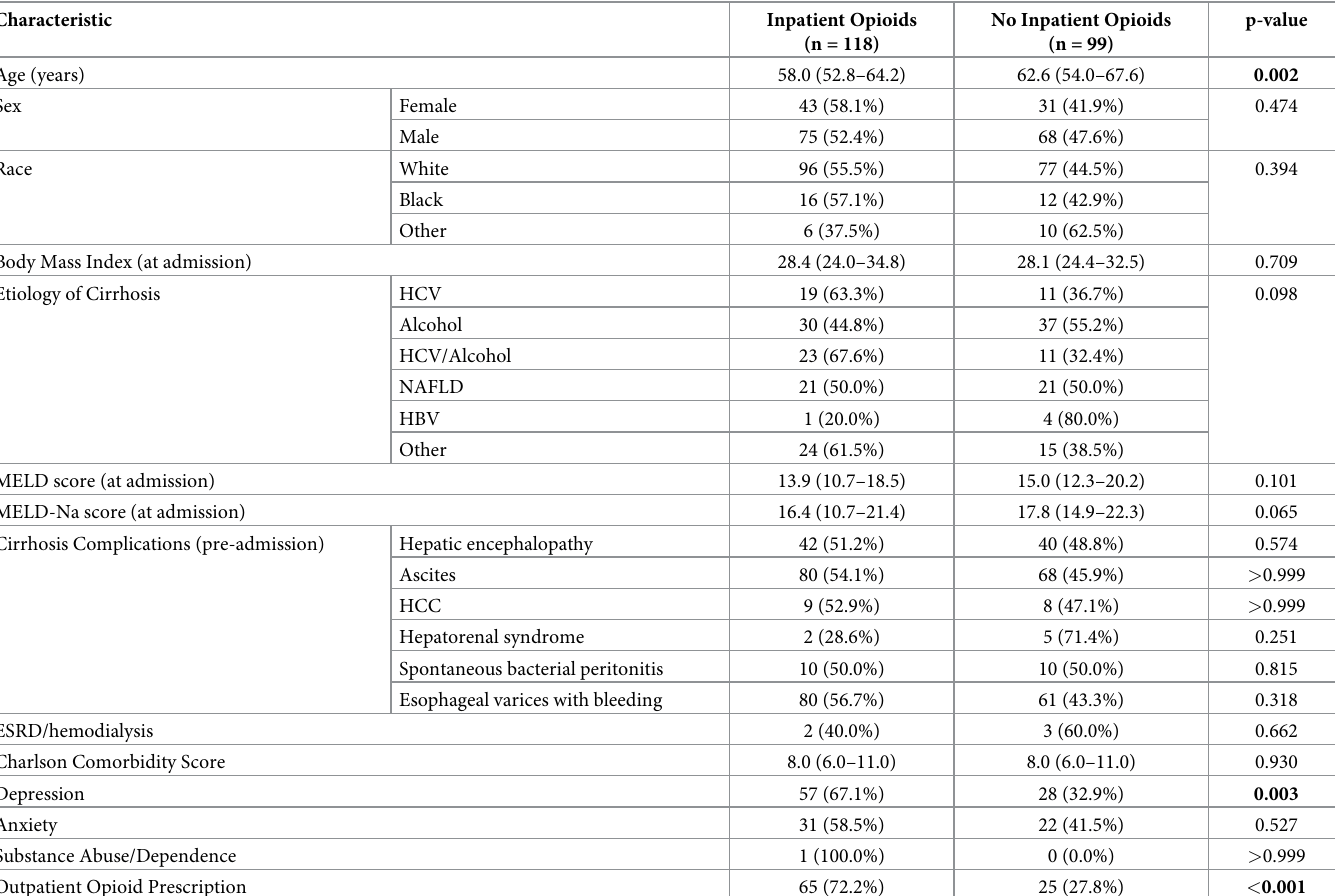
Table 2. Prevalence of inpatient opioid use by baseline